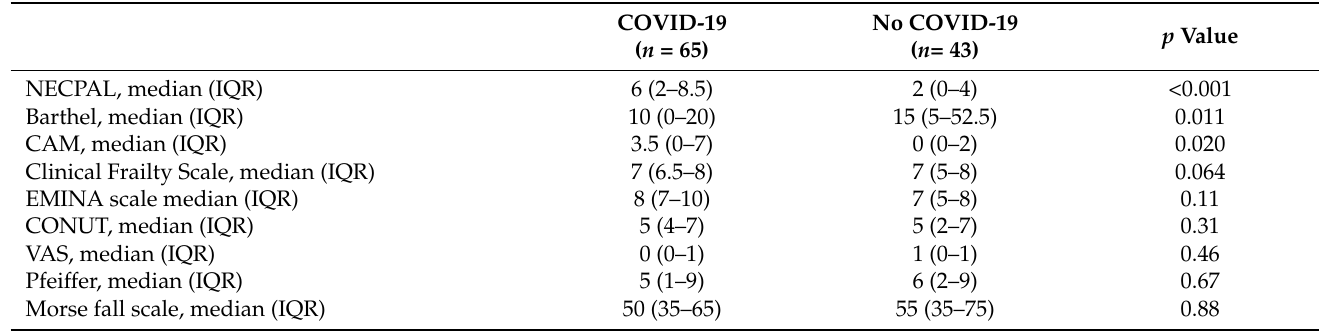
Table 2. Differences in comorbidity, frailty, and dependence scales in patients with versus without nosocomial